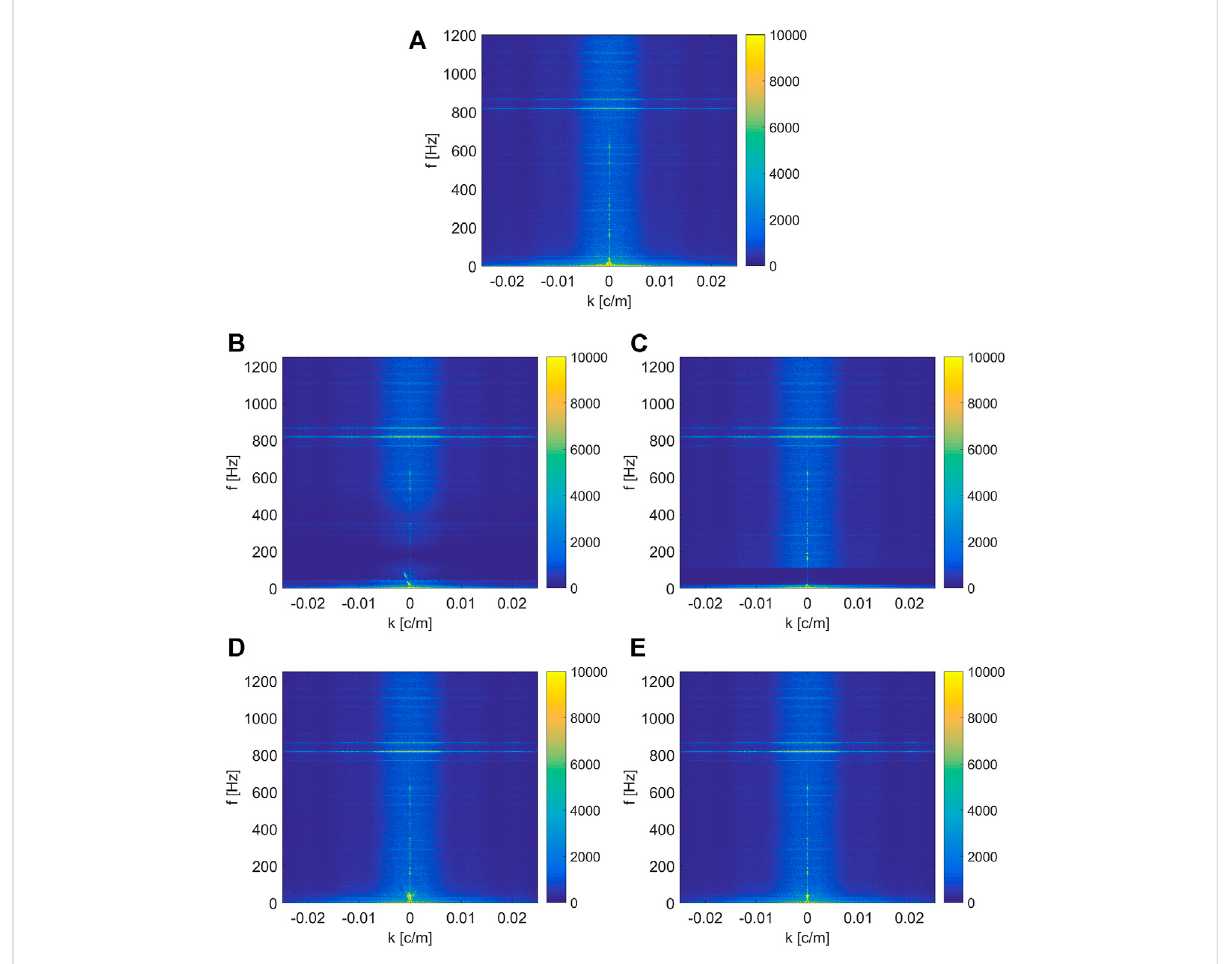
FIGURE 9 F-k spectra of difference maps. (A) F-k spectrum of Figure 5B, (B – E) F-k spectra of the difference maps in Figure